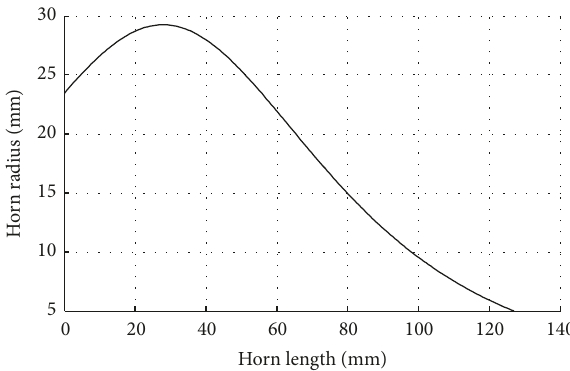
Figure 2: The half-horn shapes along the longitudinal